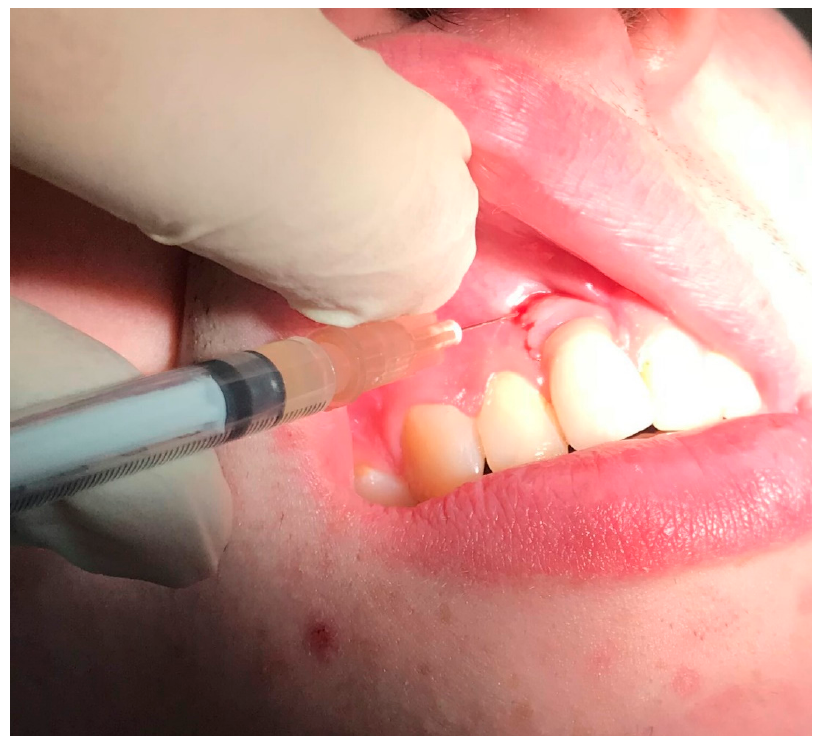
Figure 7. Application of 7% bovine collagen gel in patient in position 1.1 of dental implant.